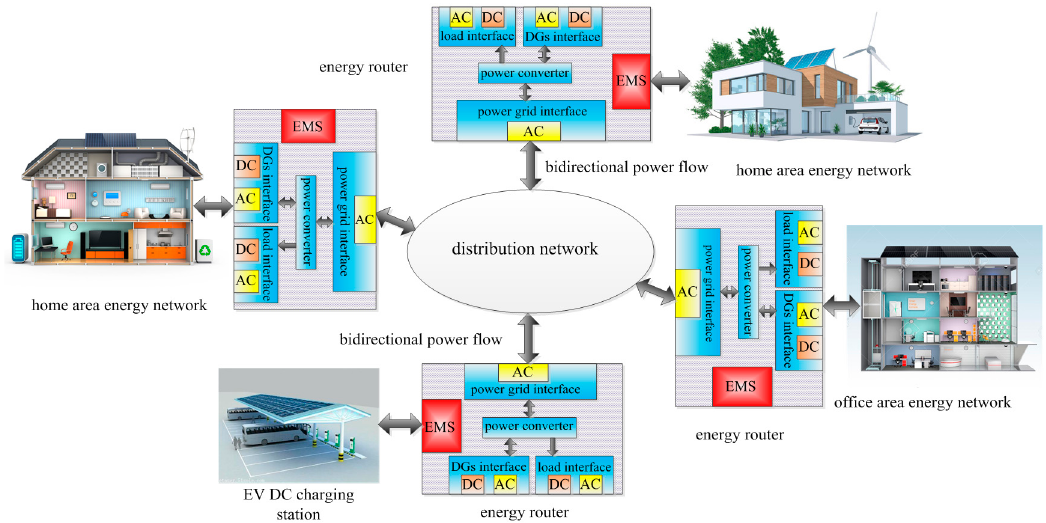
Figure 1. Architecture of the energy router-based HEMS.